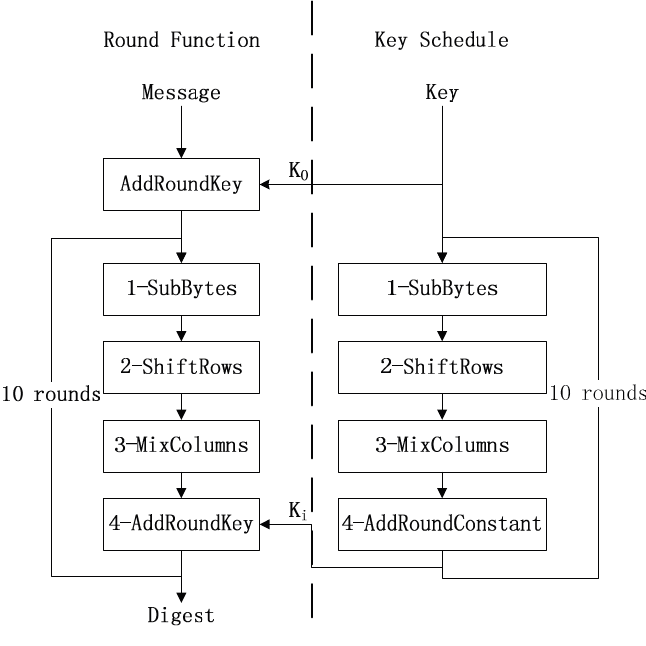
Figure 1. Procedure of